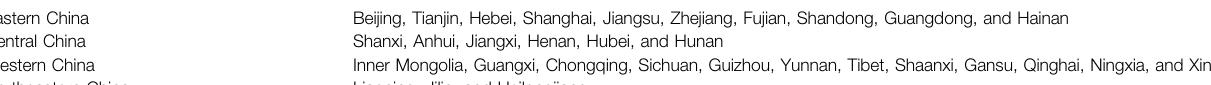
TABLE 2 | Four regions in China. Regions Provinces (Municipality Directly under the Central Government, Autonomous